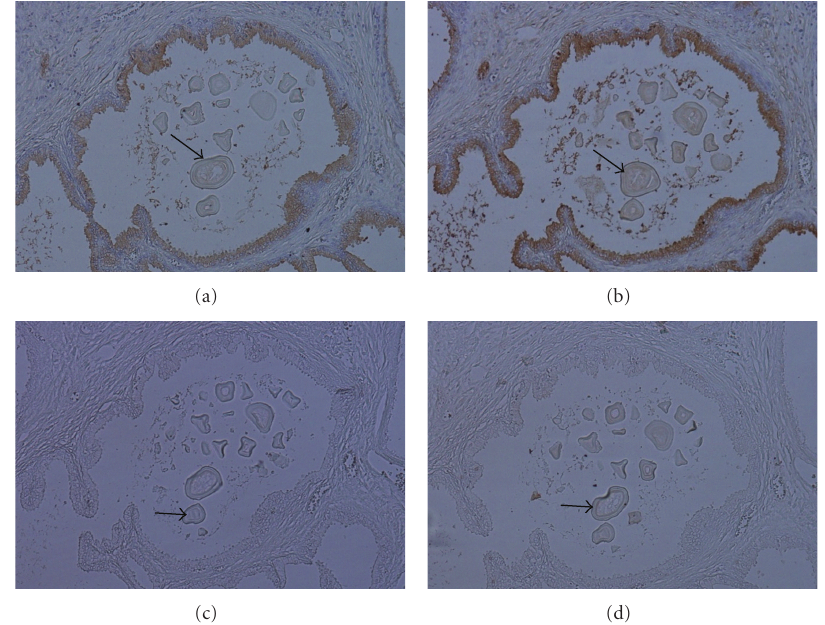
Figure 4: Lectin histochemistry of corpora amylacea ( arrows ) in BPH ((a) to (d)). In glands, corpora amylacea presented weak binding with Con-A (a) and non-staining to PNA (c); BPH glands were Cramoll 1,4 (b) and Cramoll 3 (d) moderately and weakly stained, respectively. Magnification